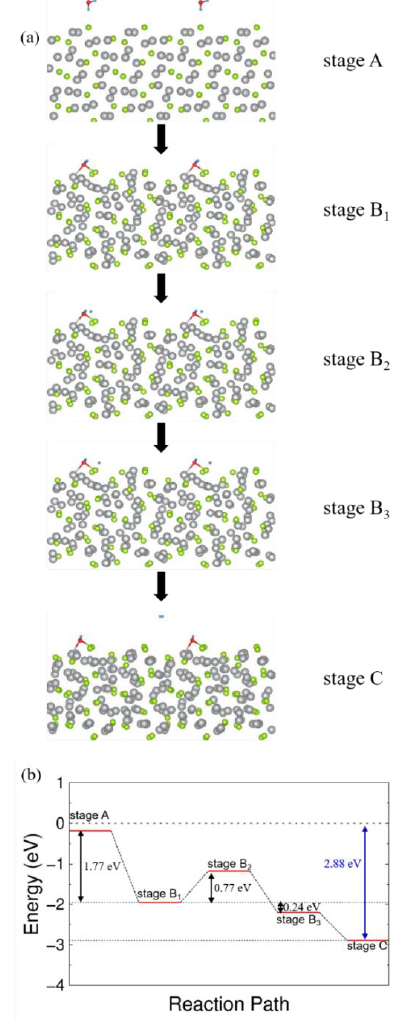
Figure 7. Adsorption process of Ag 2 Se by the DFT calculation. ( a ) At stage A, an H 2 O molecule is adsorbed on the Ag 2 Se surface. At stage B 1 , the water molecule bonds to a selenium atom of the Ag 2 Se surface. At stage B 2 , the water molecule is dissociated into an H atom and a–OH chemical group. At stage B 3 , the separated H atom bonds to an adjacent Se atom. At stage C, H atoms make molecular hydrogen gas. ( b ) The activation and reaction energies in the reaction